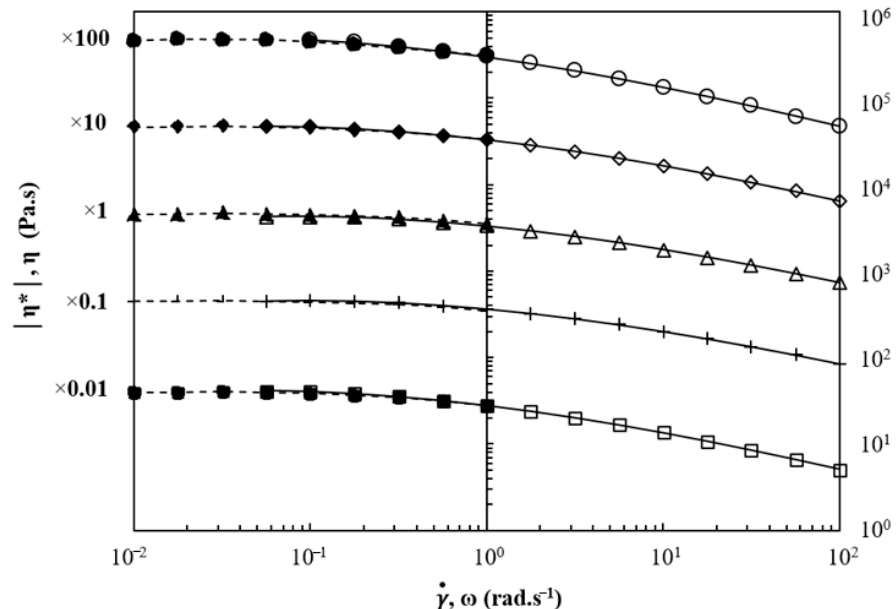
Figure 7. Cox–Merz rule and Carreau–Yasuda model applied to BPBS ( ○ ), LPBS (+), and BPBS/LPBS blends ( □ ) 80/20% ( ◇ ) 50/50%, and ( Δ ) 20/80% at 150 °C (steady shear full symbols, dashed line; oscillatory shear open symbols, Carreau–Yasuda fit solid line).